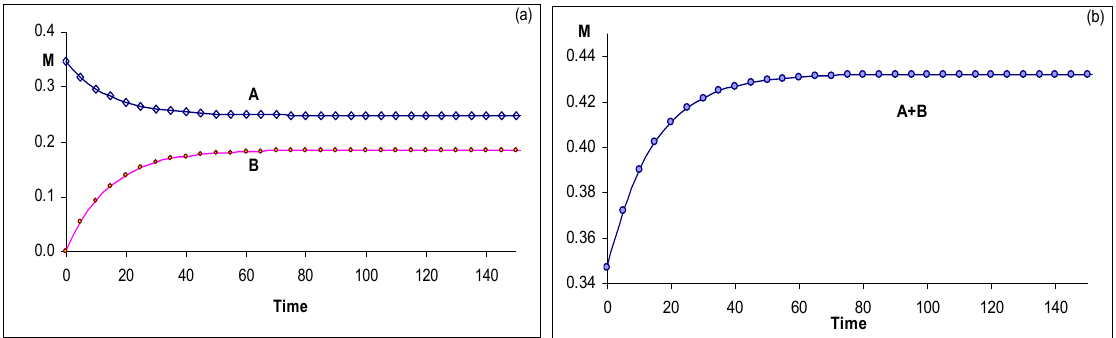
Figure 9. Examples of conmplete kinetic traces for AB(2k). (a) Observation of individual traces of species A and B. (b) Observation of the temporal evolution of the total absorbance of the same medium as in